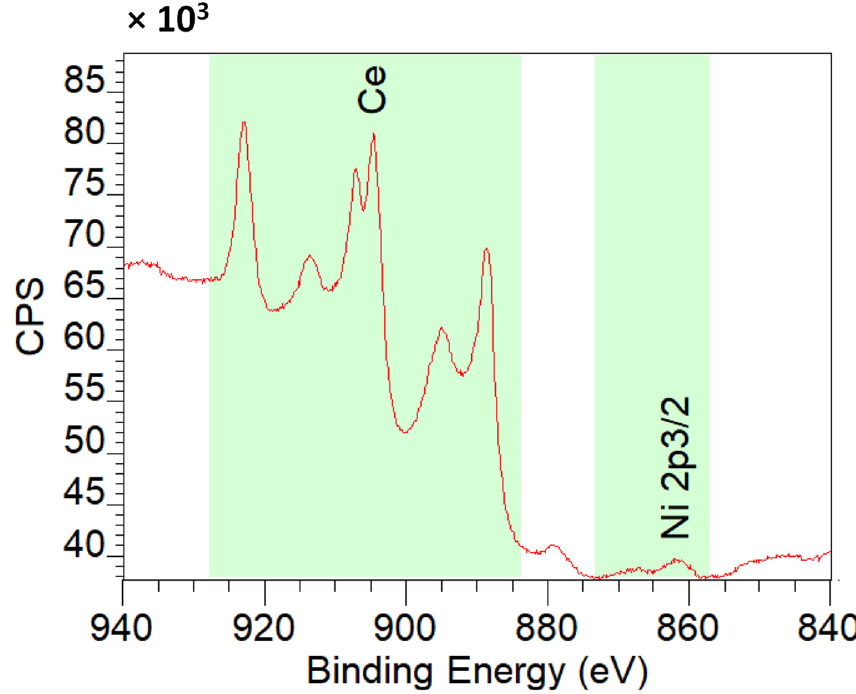
Figure 12. XPS spectra of 2%Ni-CeO 2 -rods.